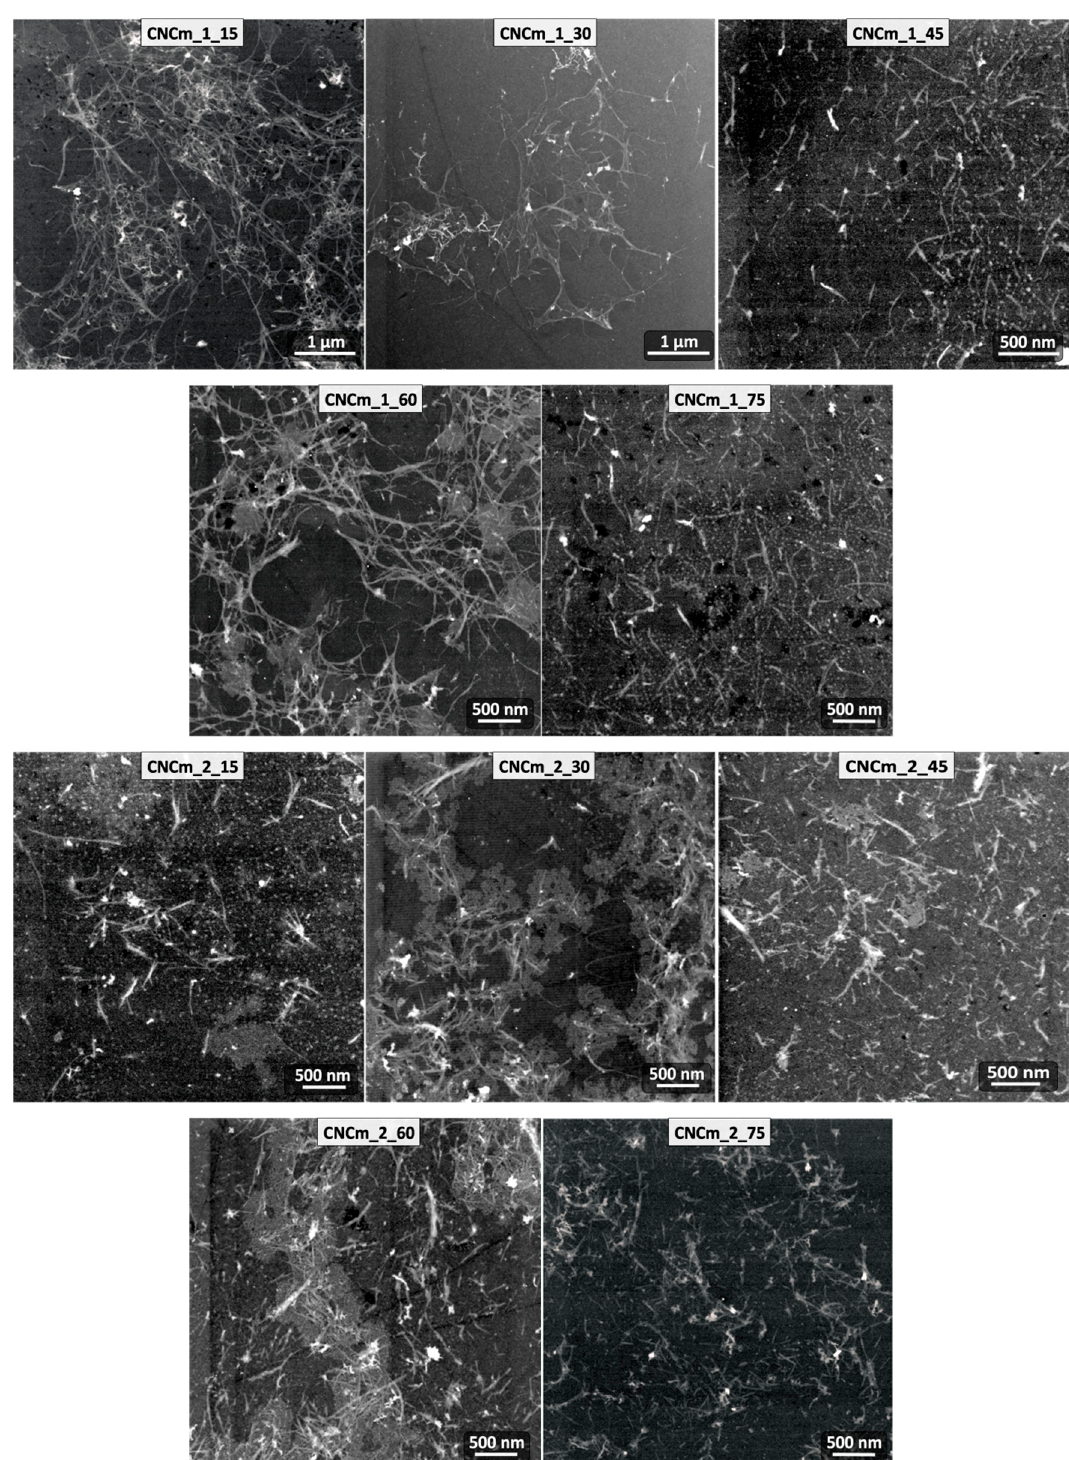
Figure 9. TEM micrographs of the CNCm samples with their respective encodings .